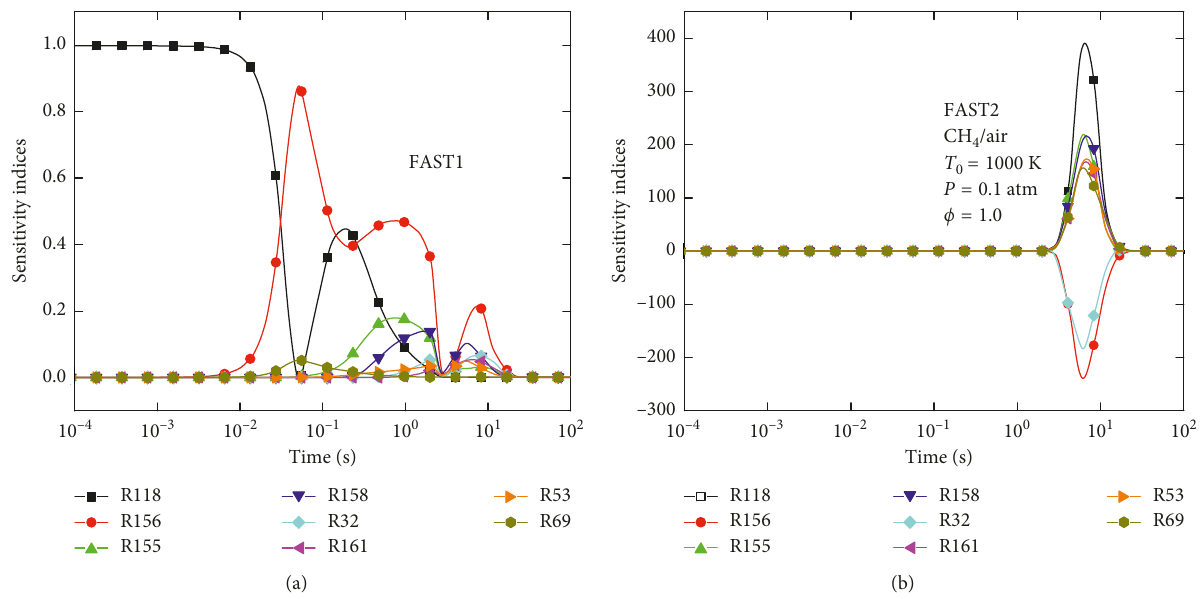
Figure 5: The profiles of sensitivity indices measured by FAST1 and FAST2 methods for CH